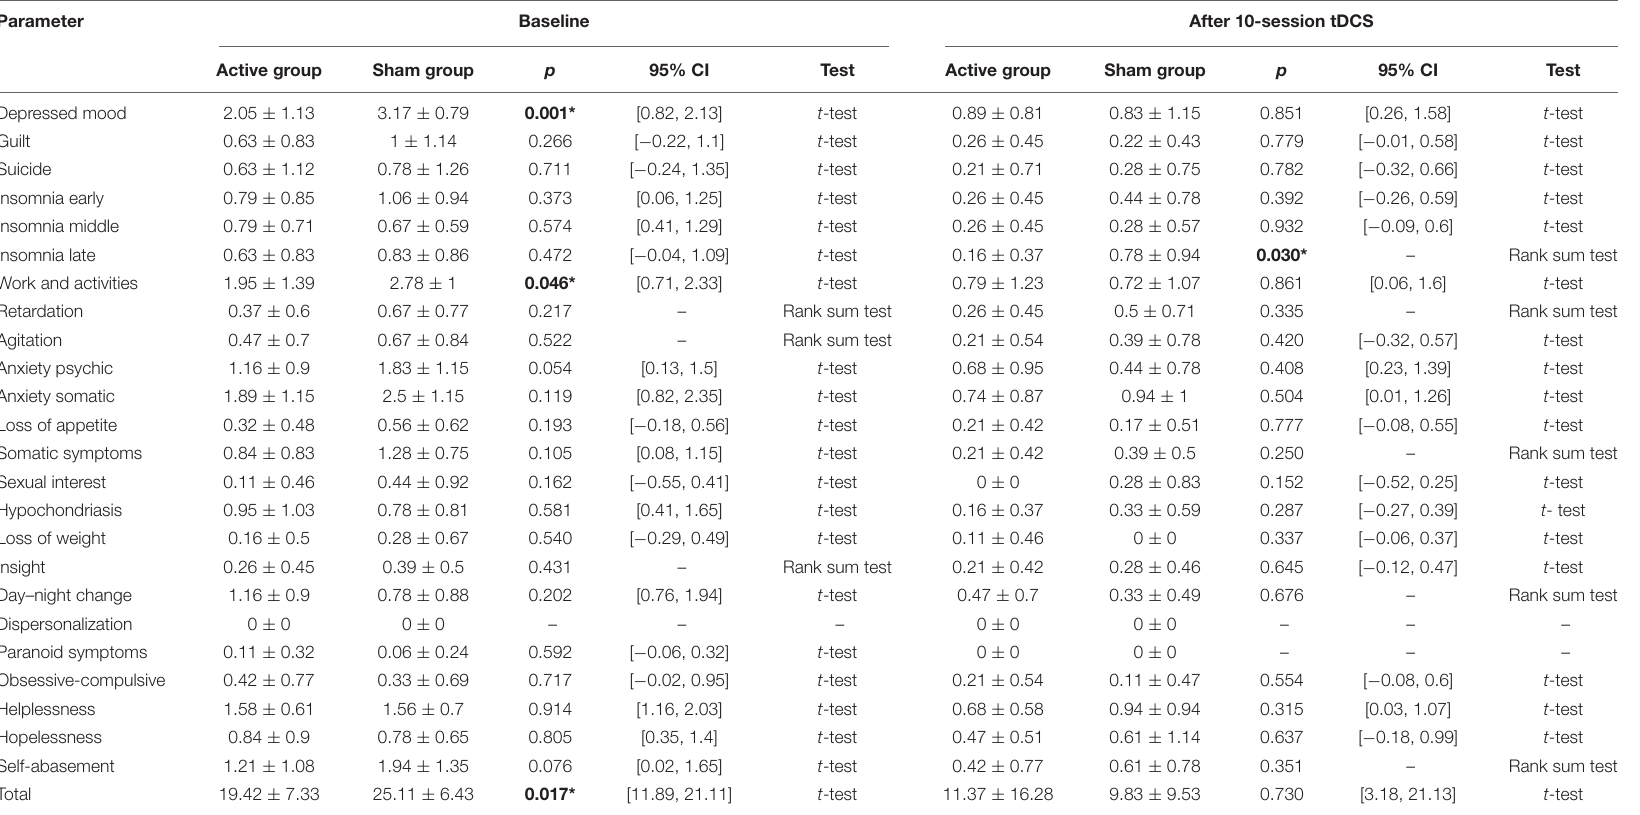
TABLE 3 | Changes in hamilton depression rating scale total score and each factor score from baseline to after